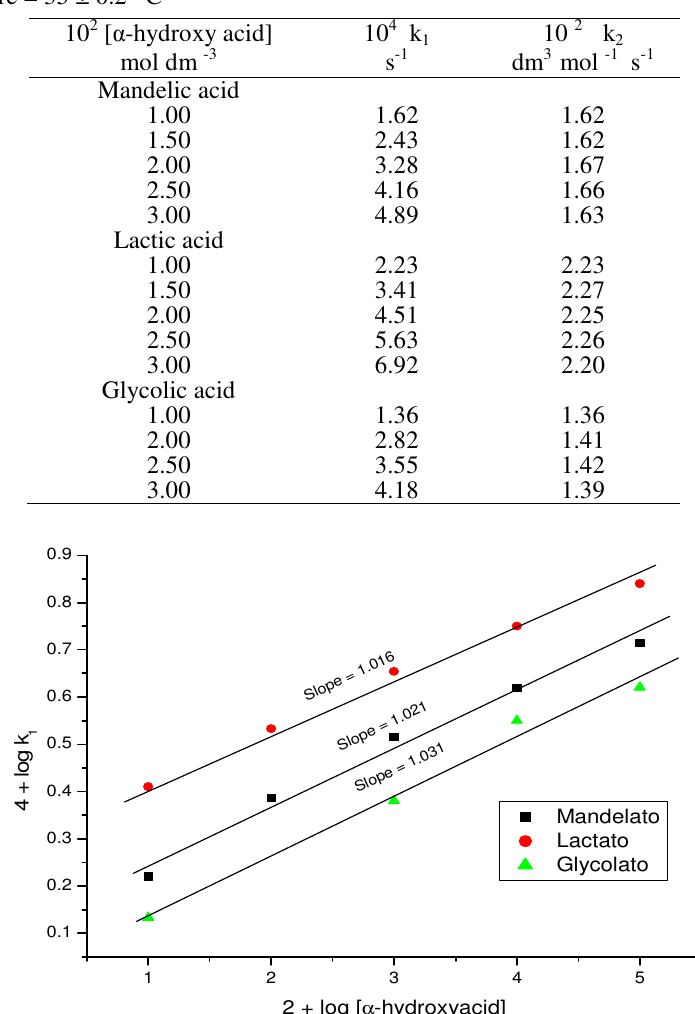
SO ] =1.00mol dm -3 , [Na LS] = 2.00 x 10 -3 mol dm -3 2 4